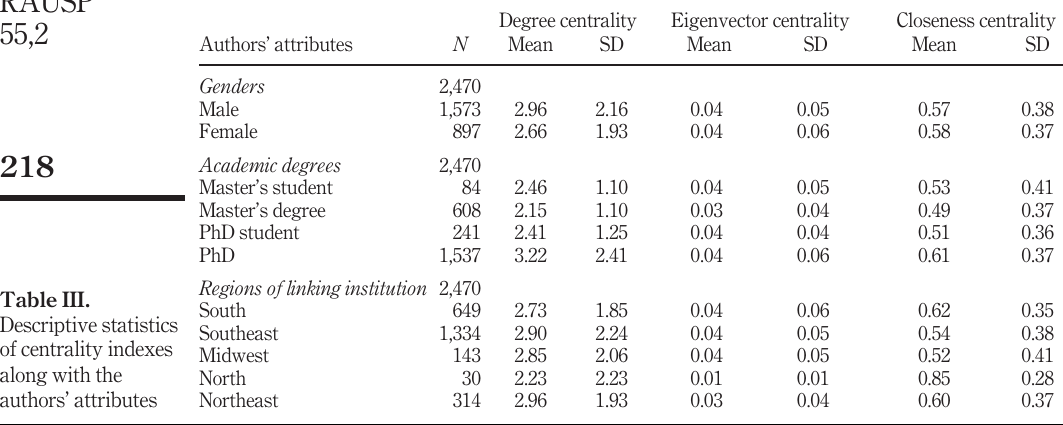
Table III. Descriptive statistics of centrality indexes